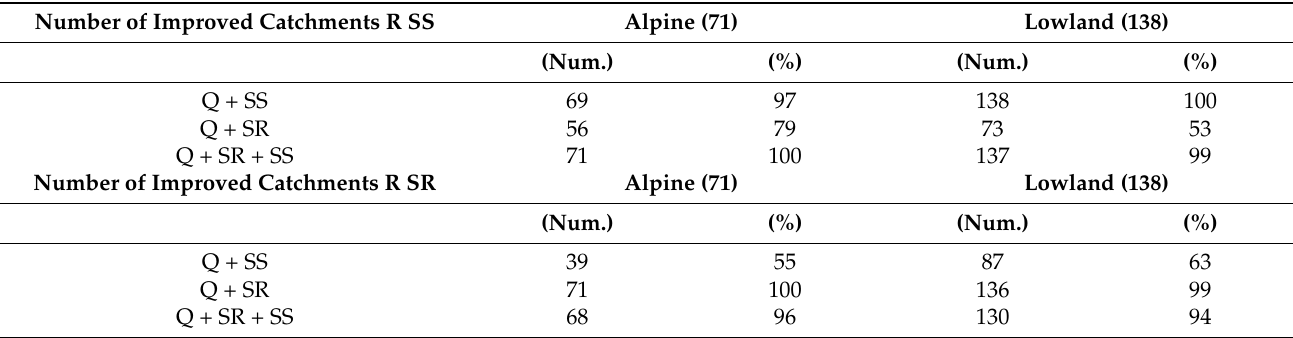
Table 6. The number of improved catchments in the correlations of the surface soil (SS) and root soil (SR) moisture, in 209 catchments in the calibration period 2007–2014.